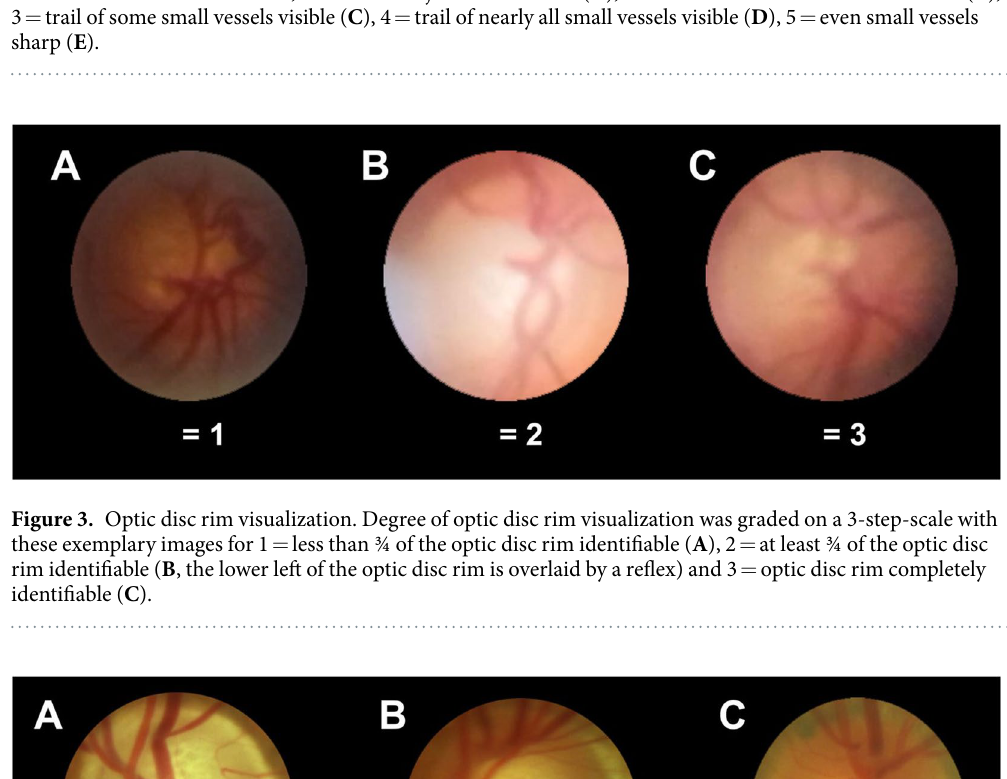
vCDR assessment on CFP correlated well with stereoscopic slit lamp biomicroscopy (Pearson coefficient of cor- relation r = 0.82, p < 0.001). There was no difference in optic disc pallor evaluation in between CFP and dilated SBFP, however there was a bias towards evaluating optic nerve heads as less pale on undilated SBFP (Fig. 7, for parametric testing see Table 2). Mean optic disc pallor ± SD on CFP and on dilated and on undilated SBFP was 1.77 ± 0.63, 1.79 ± 0.64 and 1.97 ± 0.68, respectively. Weighted kappa in between graders for optic disc pallor was 0.38. Subgroup analysis phakic vs. pseudophakic eyes. Statistically significant differences concordant to the overall analysis for image quality and degree of optic rim visualization and differences concordant, however not statistically significant, for vCDR evaluation were present (see Table 3). While a concordant, yet not statistically